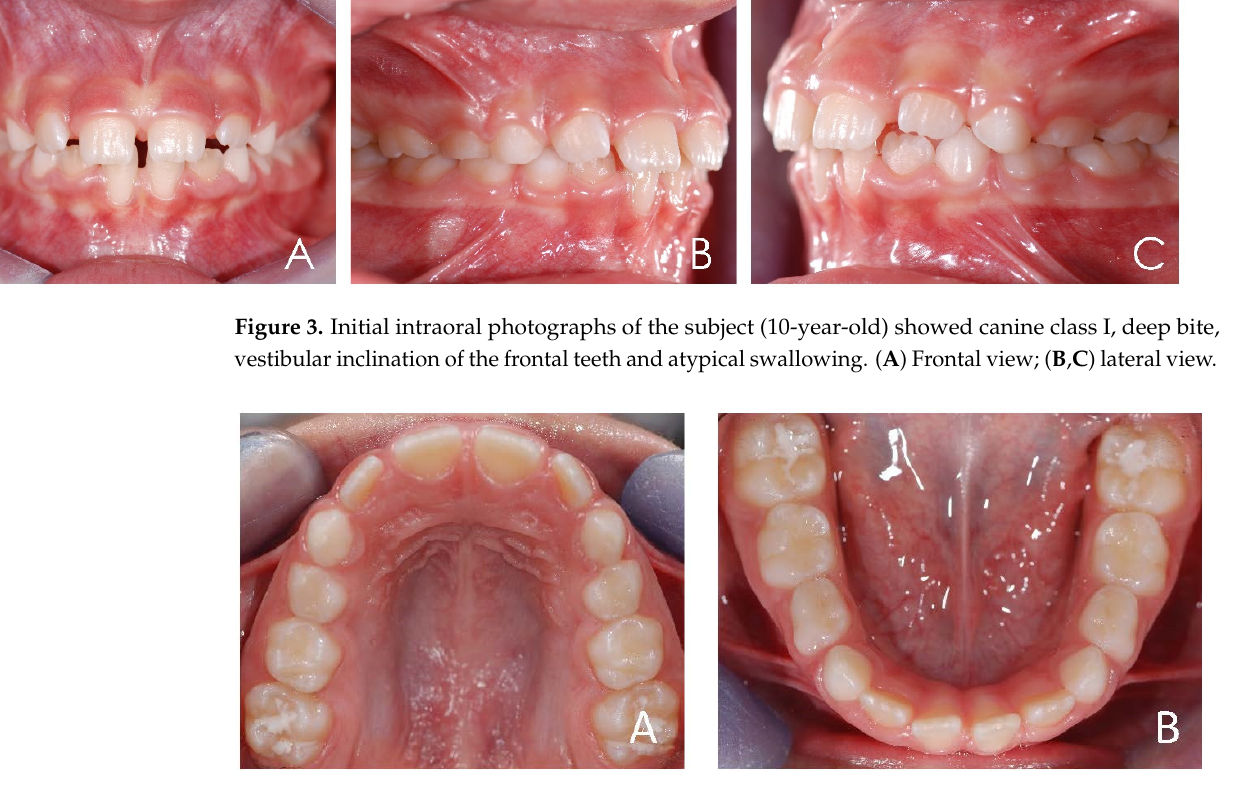
Figure 4. Initial occlusal photos of dental arches (10-year-old). ( A ) Upper arch; ( B ) lower arch.